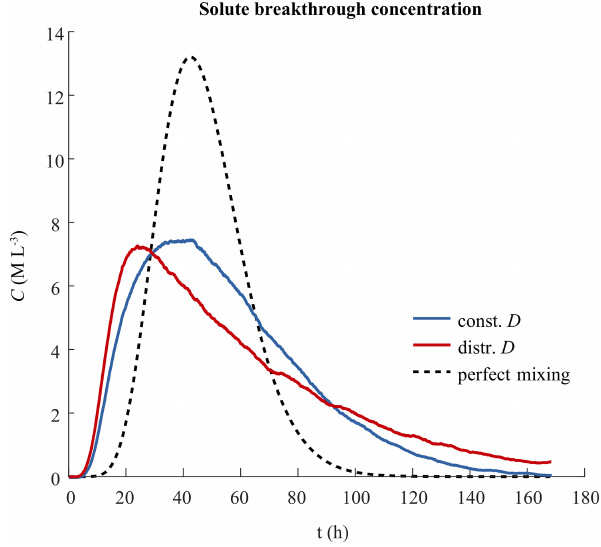
Figure 3. Solute breakthrough curves over 7d, simulated with (i) the DIPMI approach and constant D (const.) values (blue), (ii) DIPMI approach and pore-size-distributed D (distr.) values (red), and (iii) the perfect mixing assumption